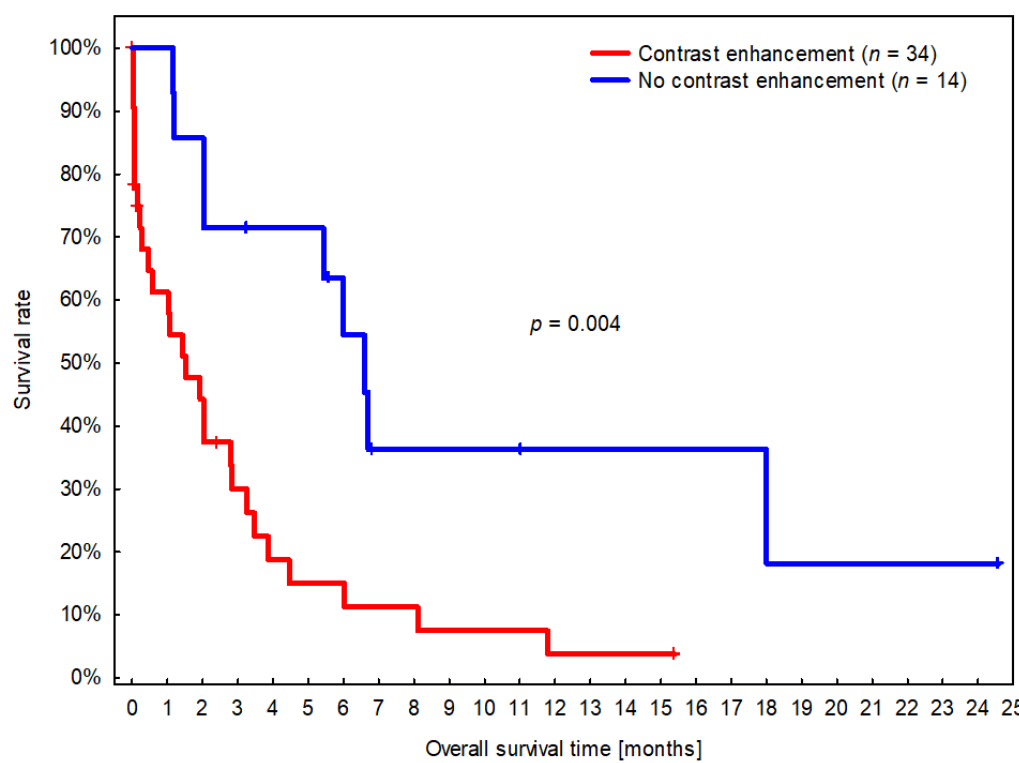
Figure 5. Kaplan–Meier survival curves for dogs with presumed glioma with and without contrast enhancement (CE). Short vertical lines signify censored dogs.